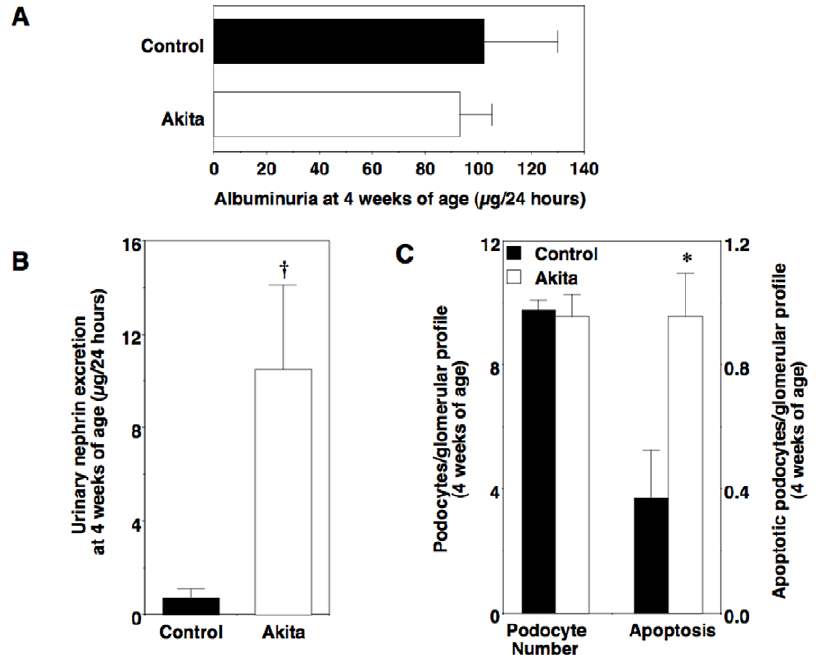
Figure 6. Podocyte injury in normoalbuminuric diabetic Akita mice. (A) Albuminuria was not significantly different in Akita mice and controls at 4 weeks of age. (B) In contrast, urinary nephrin excretion was increased in normoalbuminuric 4-week old Akita mice compared to control animals. (C) There was a significant increase in podocyte apoptosis in Akita mice compared to age-matched controls without a change in podocyte number. Black bars=control (n=6 to 8); white bars=Akita (n=6 to 8). Data are mean 6 SEM. *P , 0.05 or { P , 0.001 vs. age-matched controls.